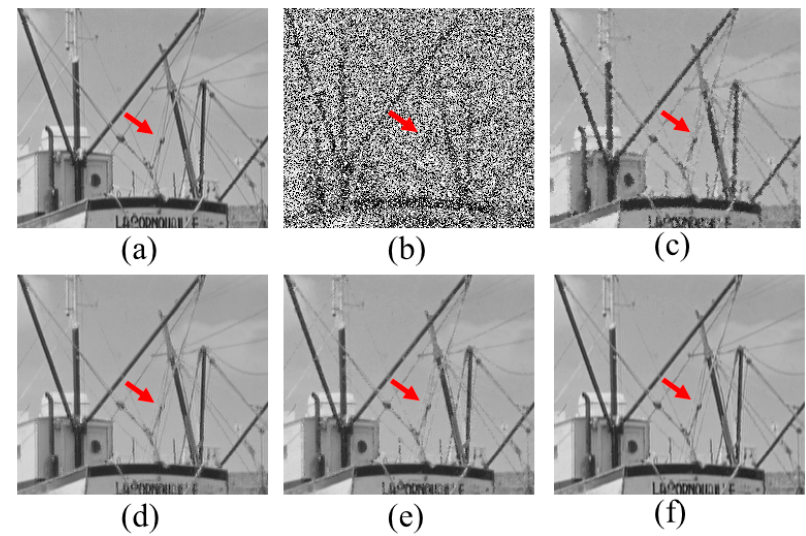
Figure 4. Denoised boat images at the noise level of 0.5. ( a ) is the noise-free image, ( b ) is the noisy image, ( c )–( f ) are denoised images using AMF, PANO-L 1 , TV-L 0 , and the proposed FDLCP-L 0 , respectively.